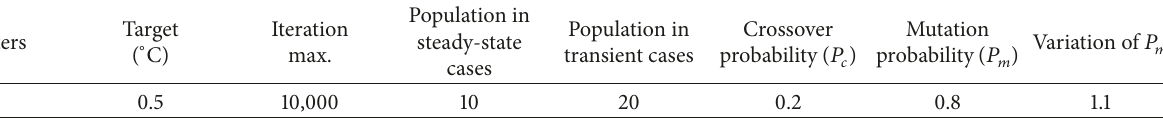
Table 1: Values of the GA definition parameters.